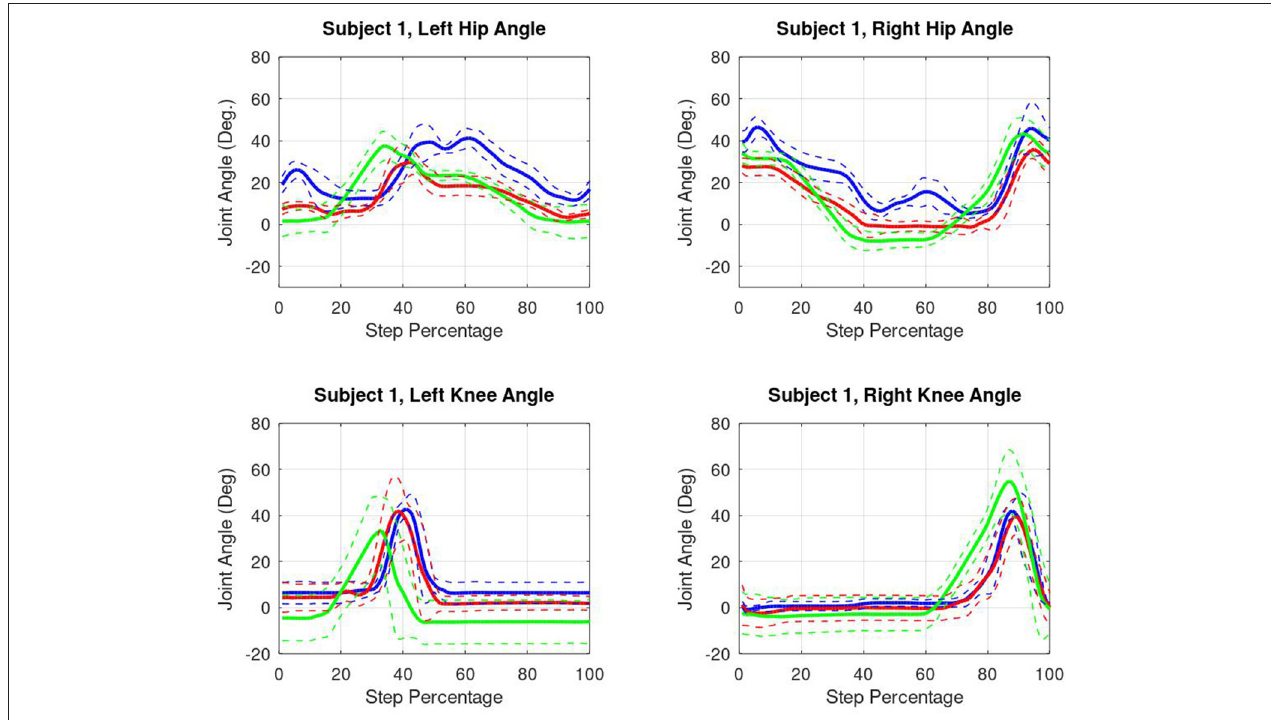
FIGURE 8 | Subject 1 kinematic results. Blue lines represent passive data. Red lines represent friction compensated data. Green lines indicate torque burst data. All data is shown right heel strike to right heel strike.